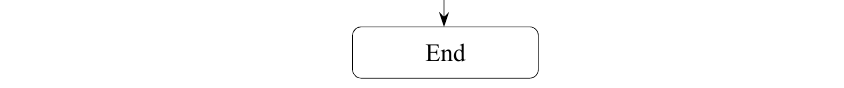
Fig. 2. Block diagram of the algorithm for minimizing losses when implementing the